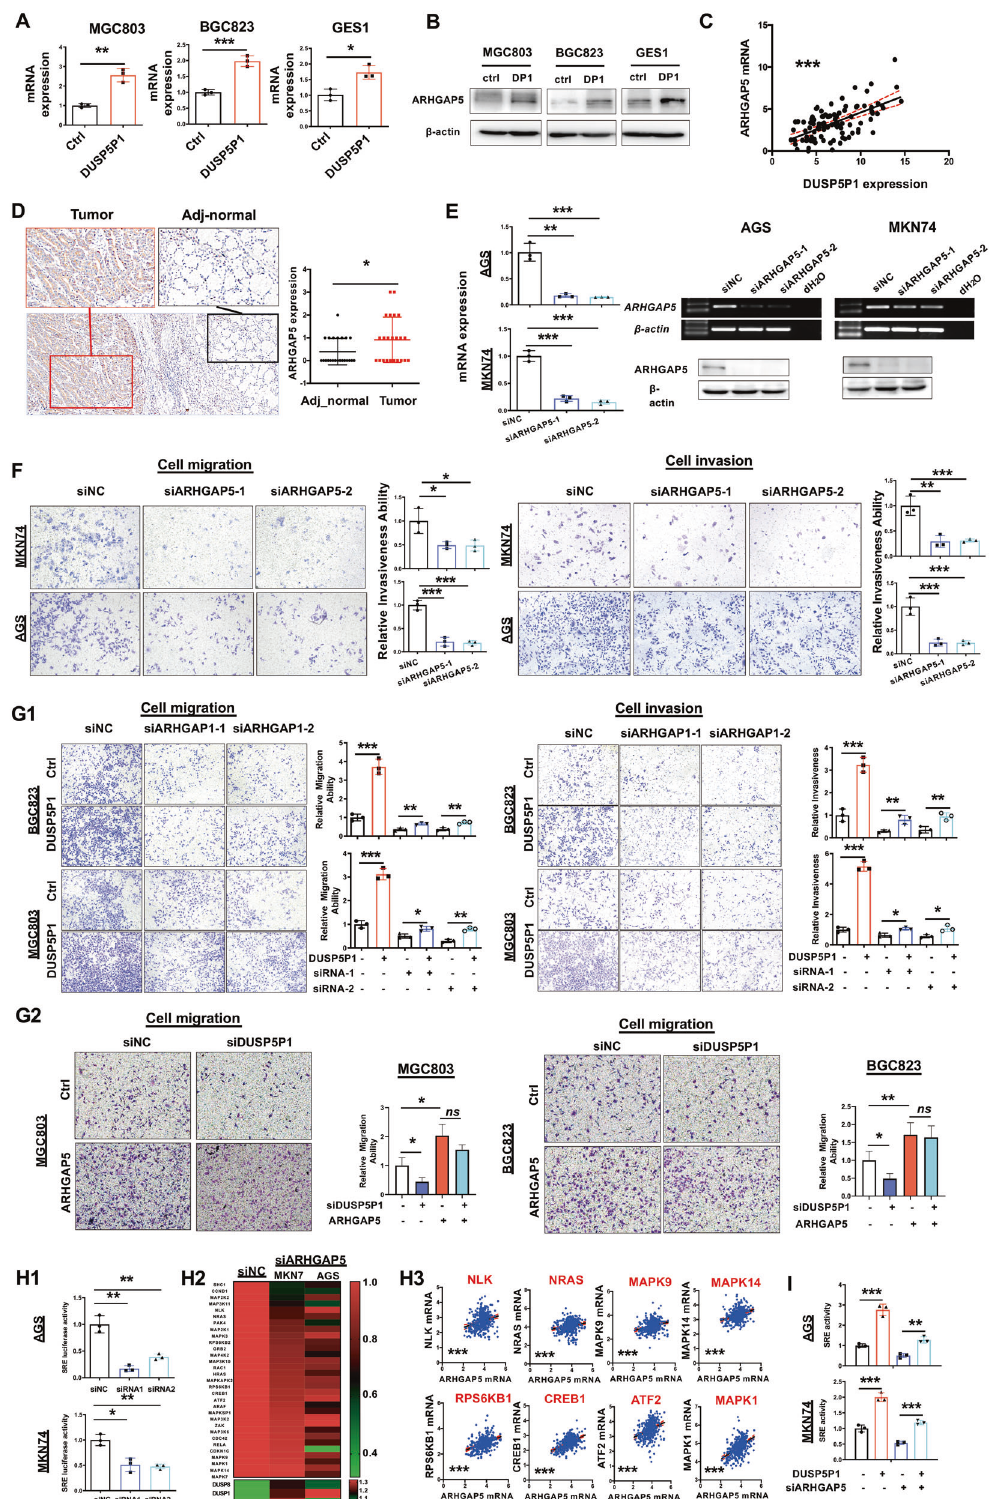
with focal adhesion inhibitor (FAK inhibitor) abolished the promoting effect of DUSP5P1 on cell migration in BGC823, MGC803, and GES1 cells. Consistent results were obtained using MAPK pathway inhibitors targeting p38 and ERK (Figs. 3F1 and F2). Hence, DUSP5P1 exerts the tumor-promoting effect by activating focal adhesion and MAPK